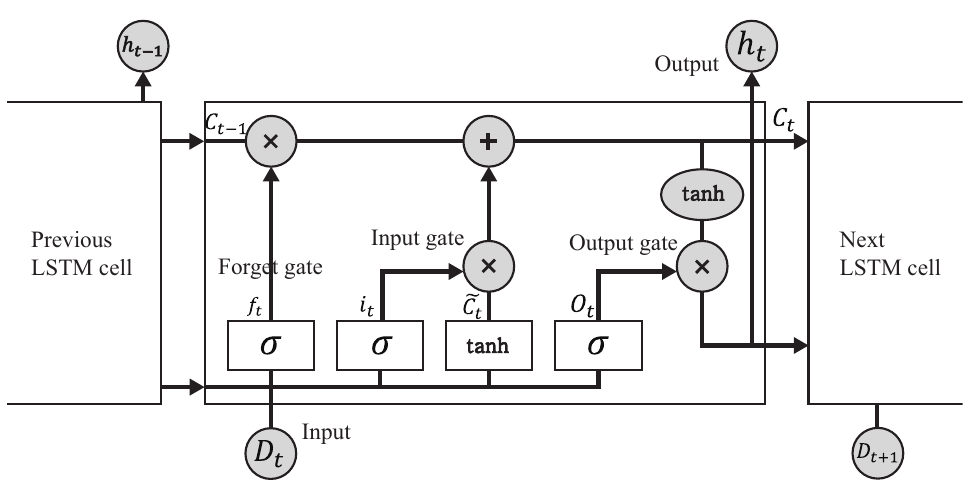
Figure 4. The architecture of the state in the LSTM